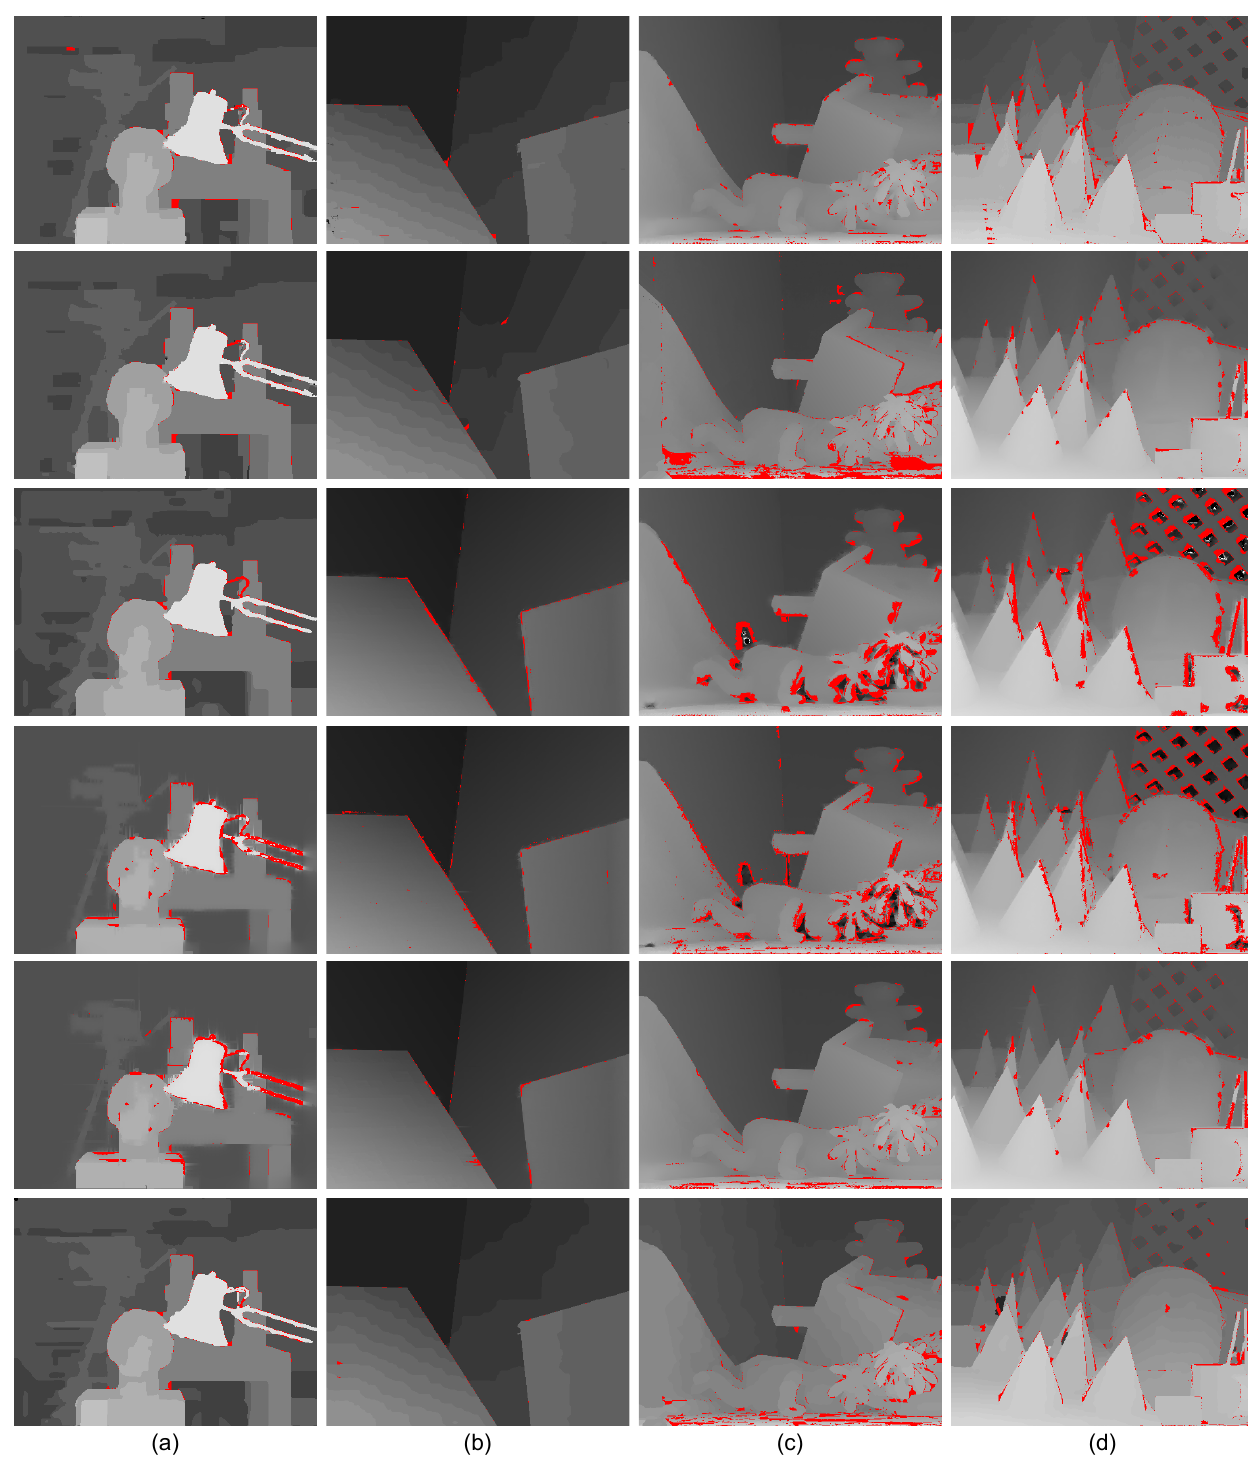
Figure 14. Evaluation results with the state-of-the-art “fused” scheme-based algorithms on the Middlebury datasets. ( a ) Tsukuba; ( b ) Venus; ( c ) Teddy; ( d ) Cones. Each column from top to bottom is the results obtained from: Zhu et al. [20], Wang et al. [23], Yang et al. [52], Jaesik et al. [53,55], James et al. [54] and our method. Error pixels with absolute disparity error larger than one in non-occlusion regions are marked red. The percentages of error pixels are listed in Table